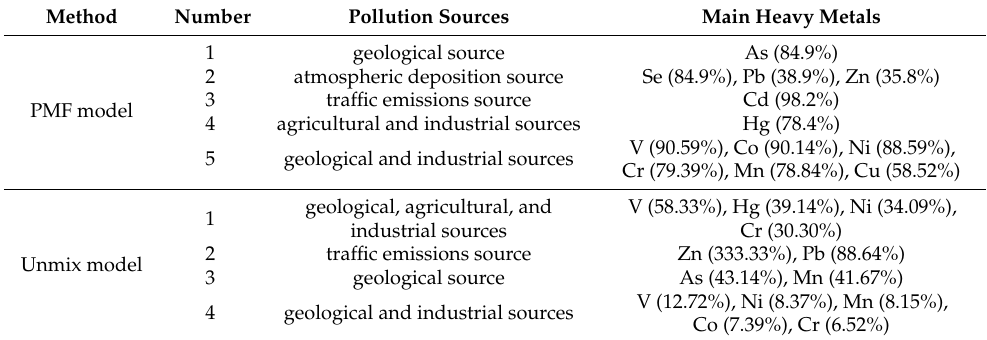
Table 3. Comparisons of the source apportionments obtained using the PMF and Unmix models.